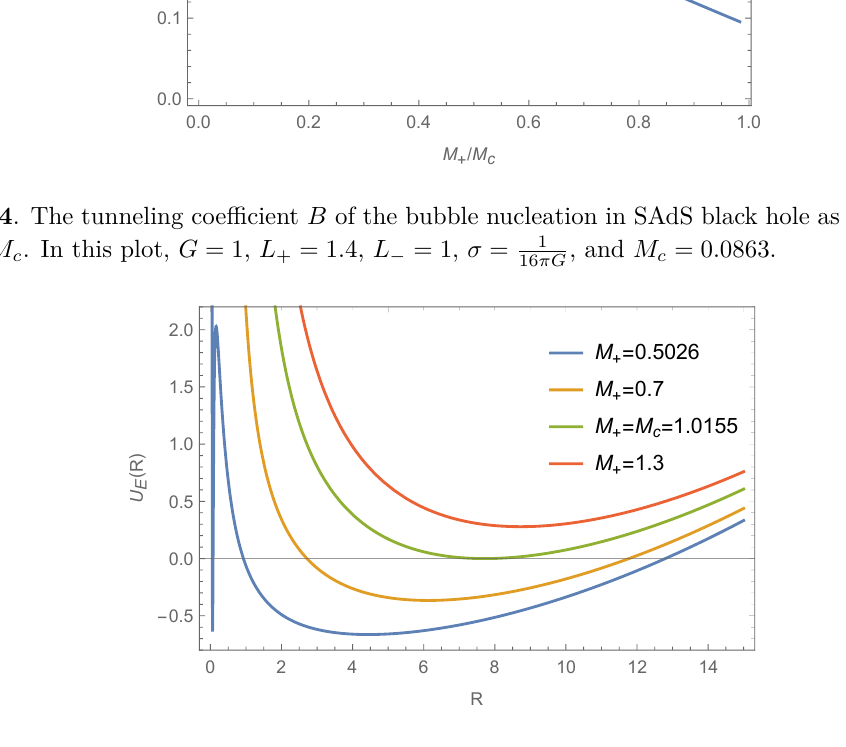
Figure 5 . The effective potential U E ( R ) with the fixed mass M − of the final black hole. In this plot, G = 1 , L + = 1 . 335 , L − = 1 , σ = 1 , Q = 0 . 3 , and M − = 0 . 5 . The critical mass of the 16 πG initial black hole is M c = 1 . 0155